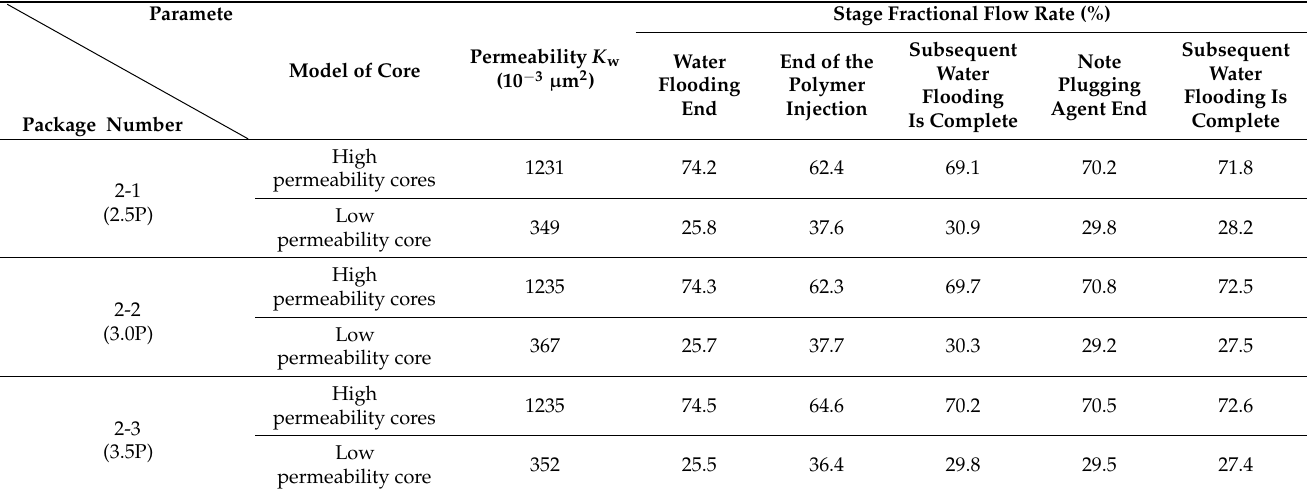
Table 3. Experimental data of diversion rate in each stage of small